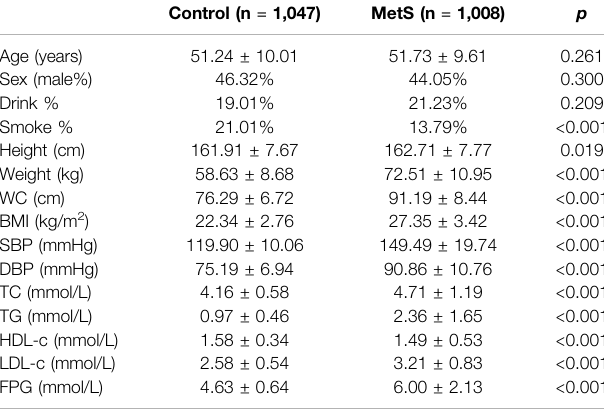
TABLE 1 | Baseline information of the control group and the MetS